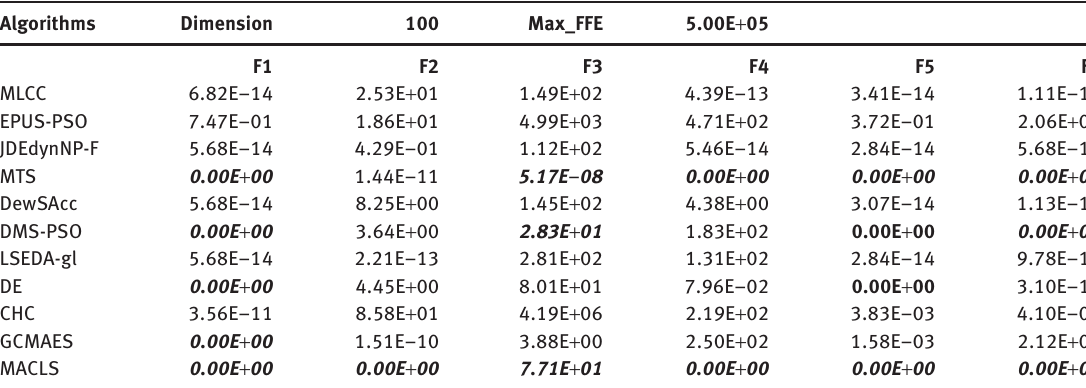
Table 6: Mean Error Values Achieved for Problems F1–F6, with D =